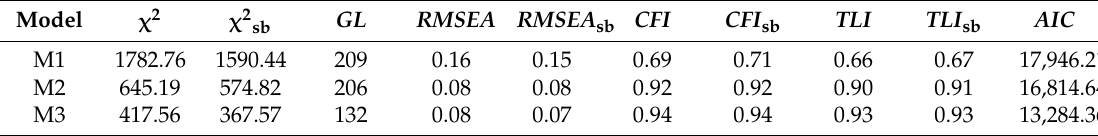
Table 3. Goodness-of-fit test for analyzed